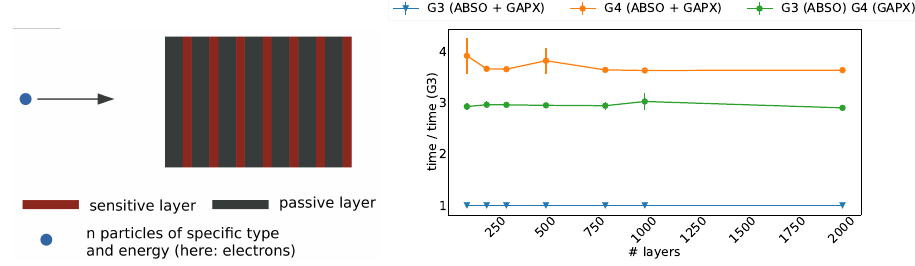
Figure 3. Sketch of a vanilla sampling calorimeter (left) and simulation time relative to the time elapsed for GEANT3 when using di ff erent engines (right) . Mixing the detailed GEANT4 simulation with GEANT3, the simulation time reduces significantly compared to using GEANT4